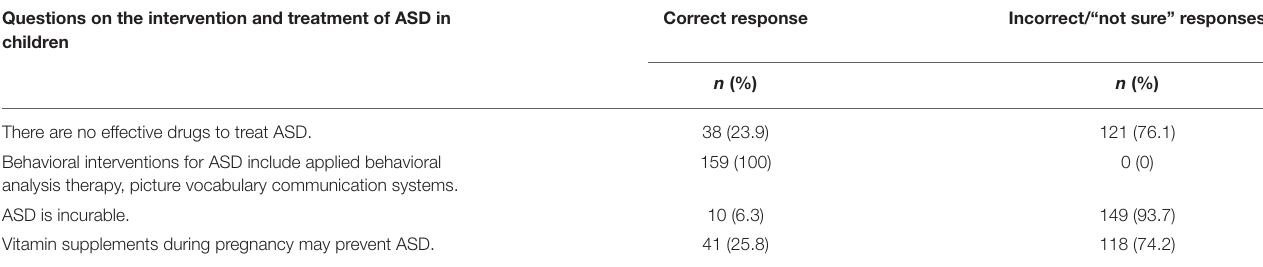
TABLE 5 | Participants’ awareness of the intervention and treatment of ASD in children. Questions on the intervention and treatment of ASD in children